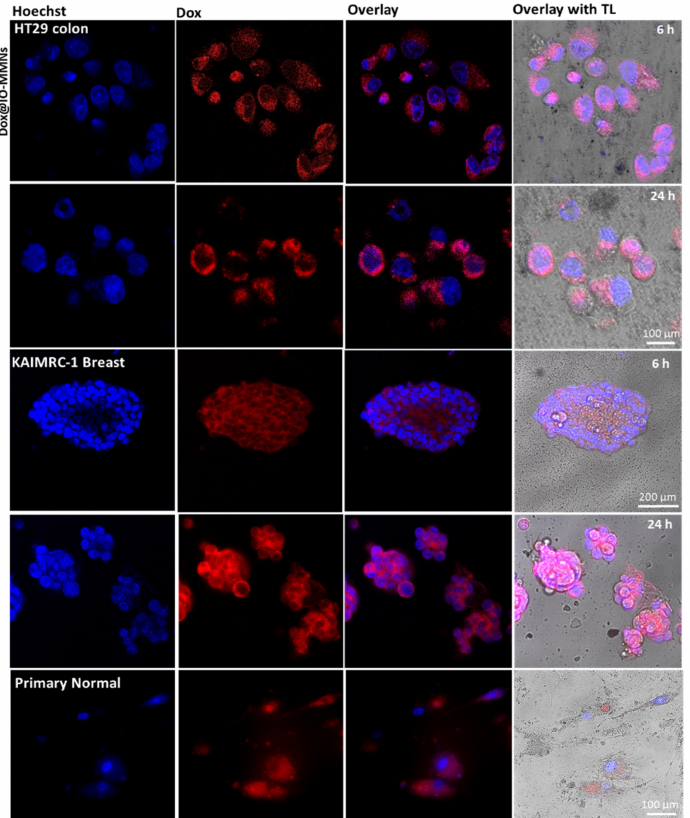
Figure 7. Live confocal microscopy images of HT-29 colon, KAIMRC-1 breast, and primary normal cells incubated with Dox@IO-MMNs (35 µ g/mL particles; 5 µ g/mL Dox). Left to right: Hoechst nuclei stain (blue), Dox channel (red), overlay of Dox and Hoechst channels, and overlay with transmitted light (TL). The confocal images show the gradual internalization of IO-MMNs inside the cell cytoplasm with time and effective delivery of Dox killing both colon and breast cancer cells but not the primary normal cells. The apoptotic features with irregular membrane blebbings are clearly seen in the cancerous cells, but not in the primary normal